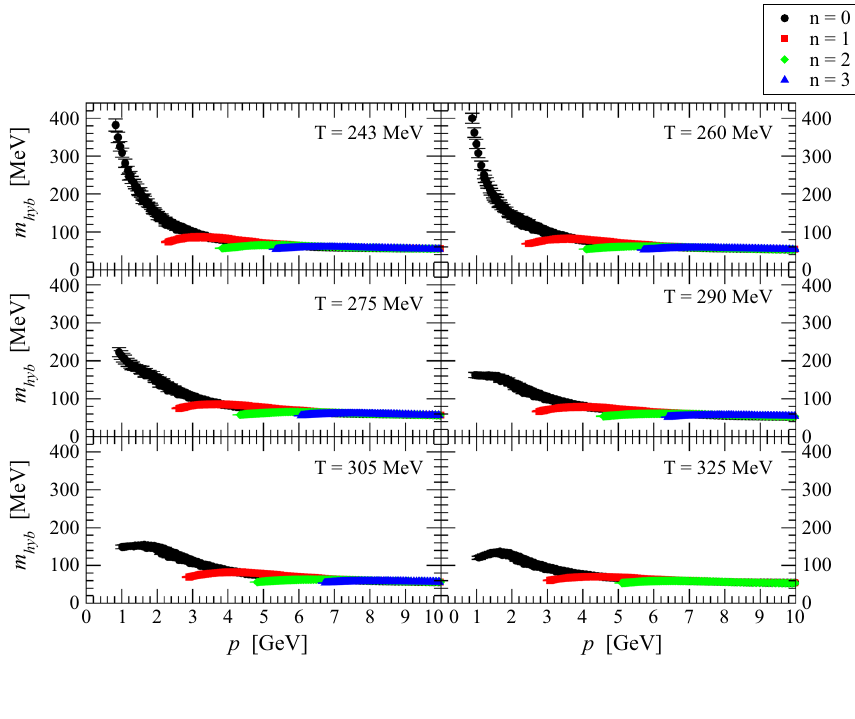
other cases that use L t = 8. It is not clear if such a short time direction is responsible for the different observed behaviour in the hybrid running quark mass. At sufficiently high p , the data shows that the running masses seem to collapse into a single curve. The data reported in Fig. 10 suggests that at high p and within the range of momenta accessed in our simulation m h ( p 4 , p ) is a decreasing function of p . We have tried to fit a constant value to the highest momenta and have verified that for p (cid:2) 10 GeV the lattice data for m h ( p 4 , p ) is compatible with a constant just above 50 MeV; for example, for T = 290 MeV, we get m h = 51 . 984 ± 0 . 030 MeV with a χ 2 / d . o . f = 1 . 1 for p > 9 . 8 GeV. This fit value for the mass Fig. 11 The running quark mass m h ( p 4 , p ) for all the T and for all Matsubara frequencies computed for the simulations using m bare ∼ 50